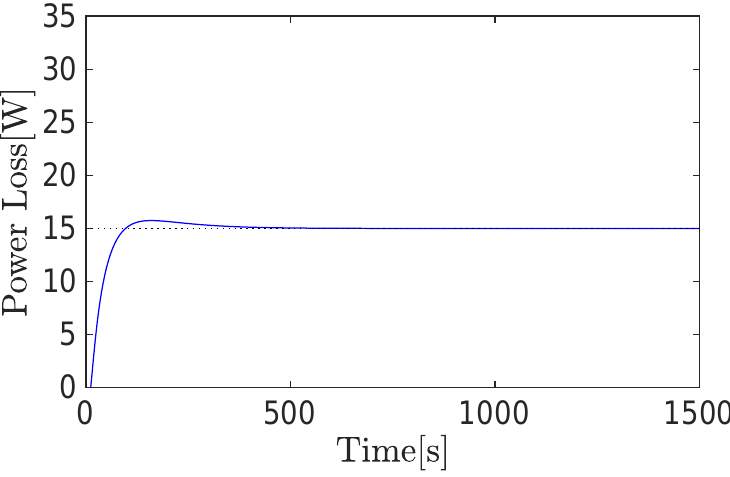
Figure 10. Endothermic quantity of Peltier device u c .